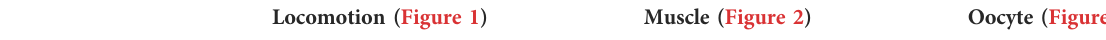
TABLE 1 IC 50 for two types of AChRs estimated from three